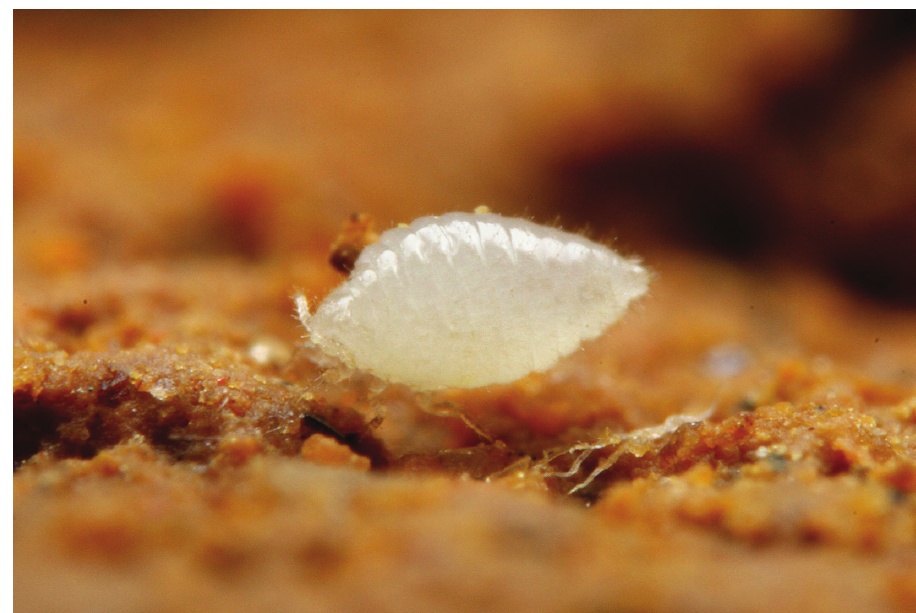
Figure 1. A mature adult female of Ishigakicoccus shimadai sp.